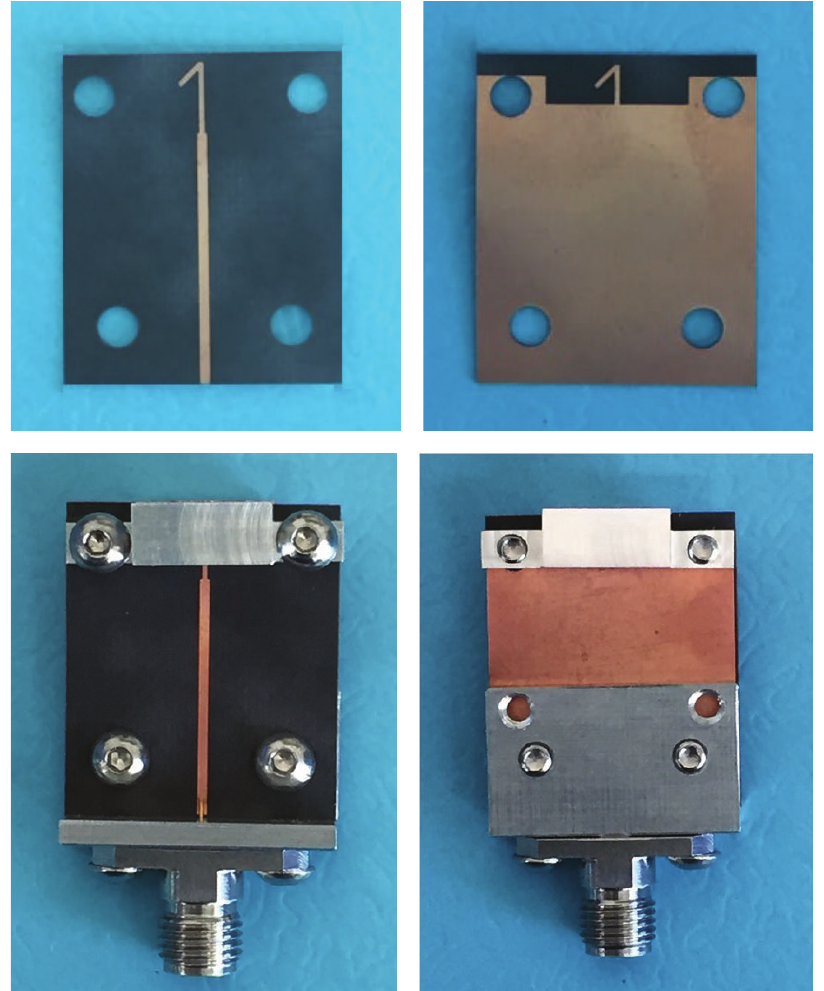
Figure 3: Fabricated sample of the cavity-backed angled-dipole antenna including jig and 2.92 mm SMA